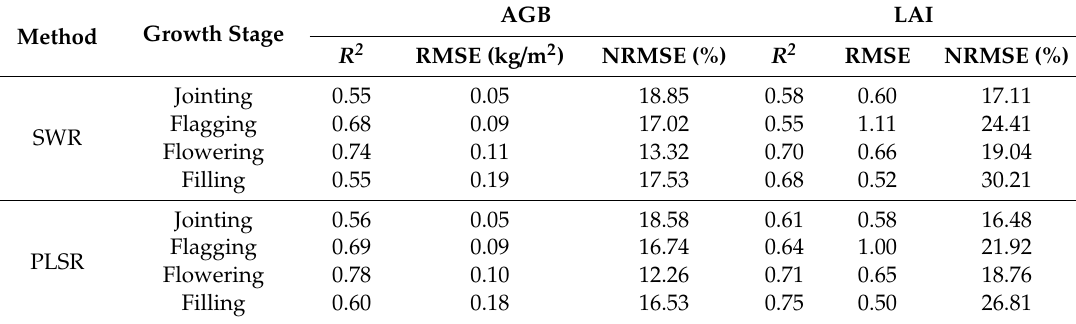
Table 7. Performance metrics for the estimation of winter-wheat AGB and LAI obtained using seven vegetation indices (modeling dataset) and either the stepwise regression (SWR) or partial least squares regression (PLSR) method for the four growth